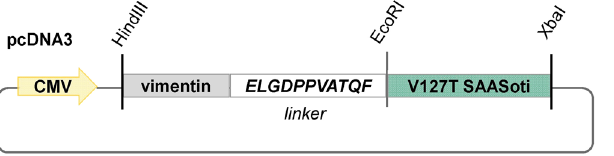
Figure 12. Scheme of V127T SAASoti fusion to the C-terminus of vimentin-gene via ELGDPPVATQF-linker cloned into pcDNA3 vector